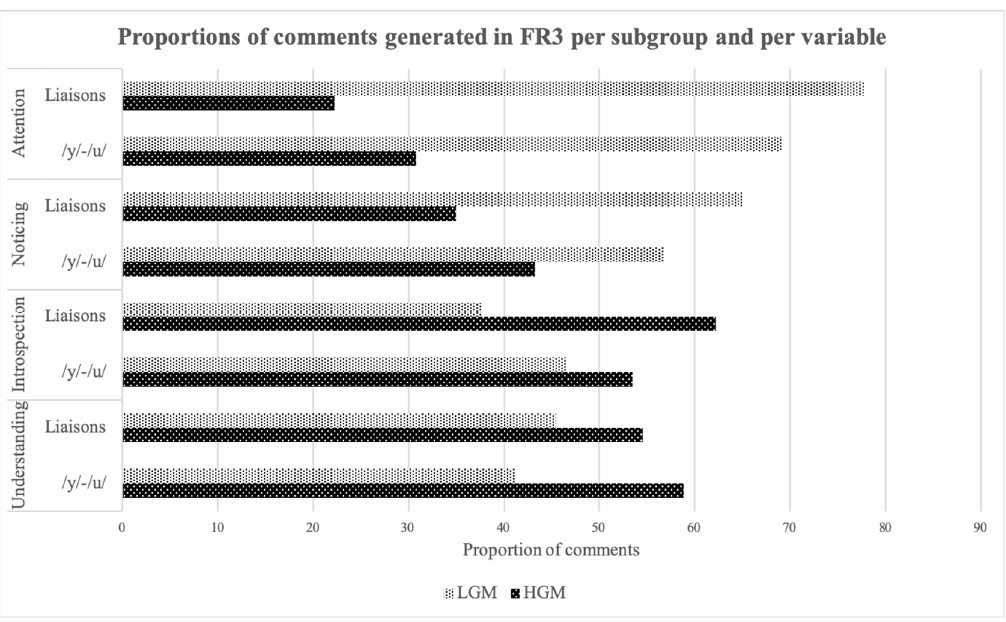
Figure 5. Proportions of comments generated in FR3.